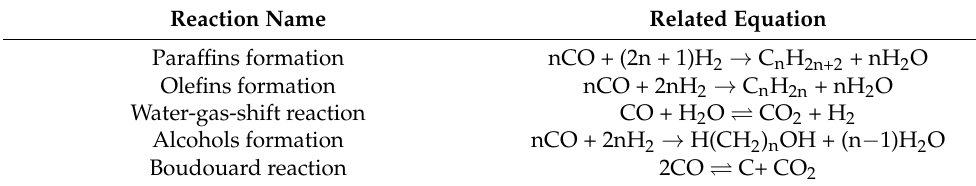
Table 1. Significant reactions in Fischer–Tropsch synthesis (FTS) [5].